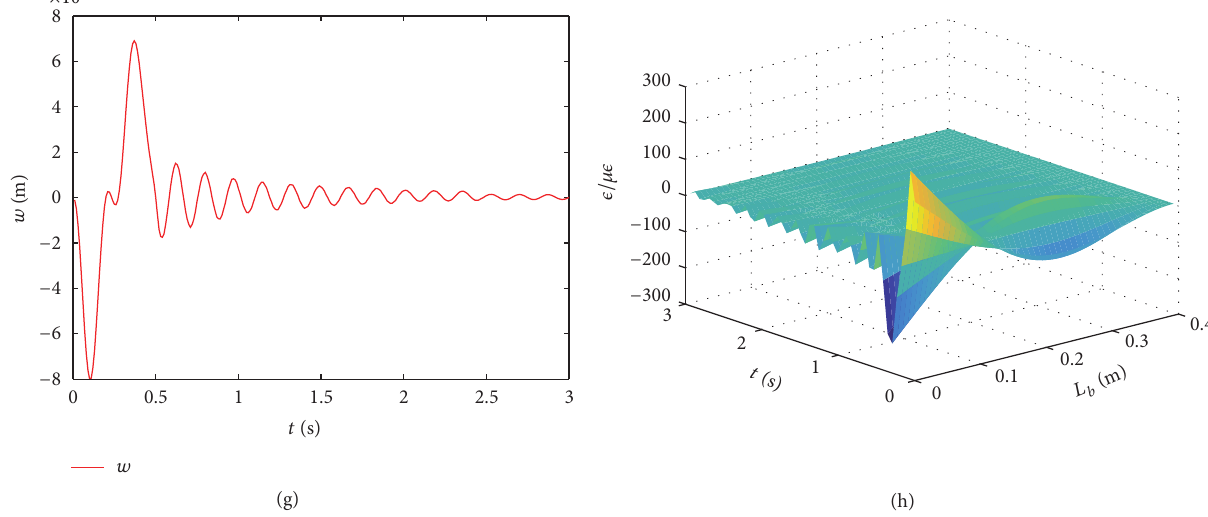
Figure 11: Simulation curves of composite control for trajectory tracking and vibration suppression of the SFM ((a) time-varying control variable; (b) control torque; (c) control voltage; (d) tip angle; (e) first-order modal coordinate; (f) second-order modal coordinate; (g) tip deflection; (h) strain time history).